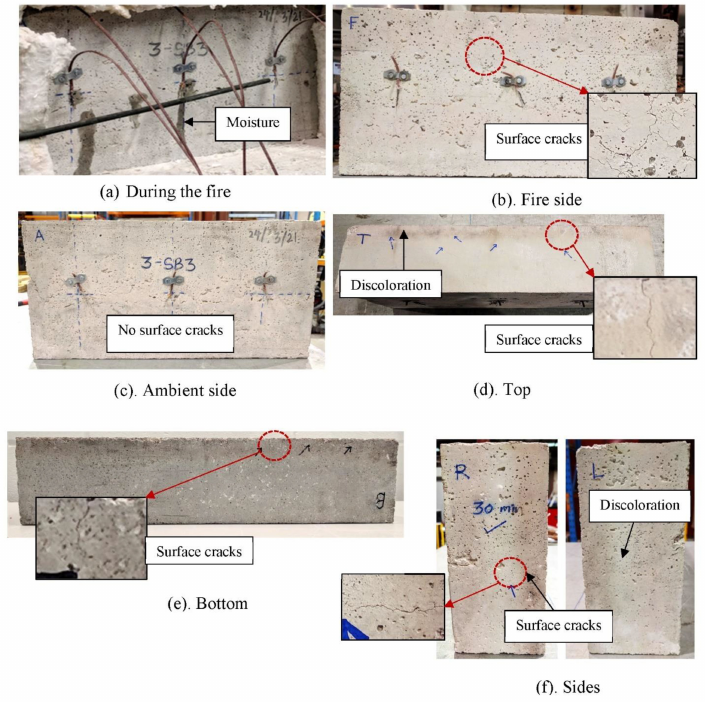
Figure 15. C-S block surfaces ( a ) during and ( b – f ) after the bushfire test. Figure 16 and Table 5 show the time–temperature curves of the fire and ambient side surfaces of C-S blocks from the bushfire test and a summary of the bushfire test results, respectively. The initial ambient surface temperature was 20 ◦ C. At the end of the heating phase (i.e., after 30 min), the average temperature on the fire and ambient side surfaces were 773 and 71 ◦ C, respectively. Then, the temperature on the fire side surface started to decrease while the temperature on the ambient side surface started to increase. A maximum ambient surface temperature of 89 ◦ C was recorded during the cooling phase at 55 min, after which the ambient surface temperature started to decrease as well. At the end of 90 min of testing, the average ambient side surface temperature was 76 ◦ C. Table 5. Bushfire test results for C-S and C-PE